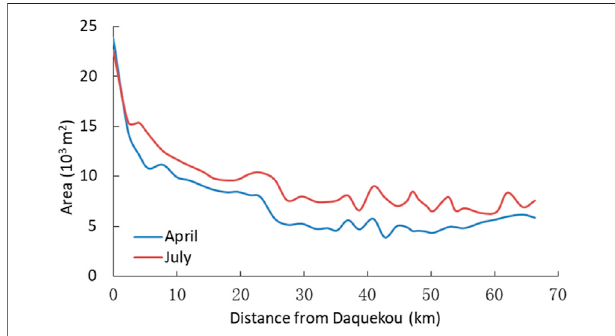
FIGURE10| The cross-sectionalareas upstreamDaquekou beforeand after the river fl ood.